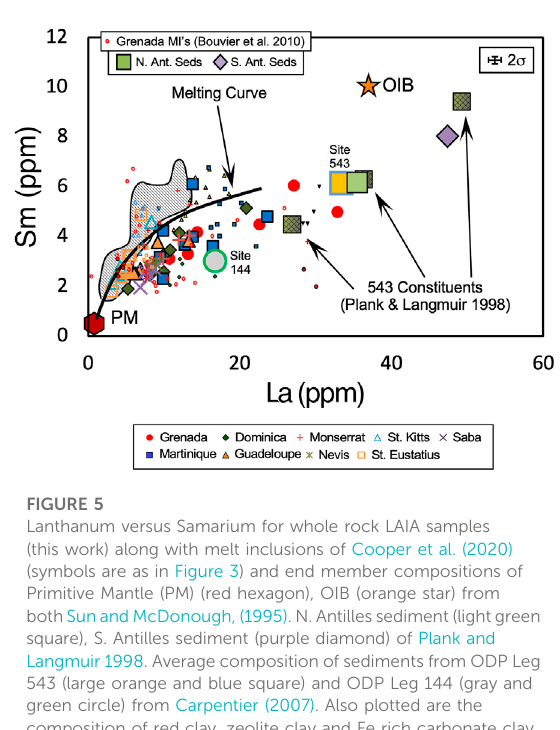
FIGURE 5 Lanthanum versus Samarium for whole rock LAIA samples (this work) along with melt inclusions of Cooper et al. (2020) (symbols are as in Figure 3) and end member compositions of Primitive Mantle (PM) (red hexagon), OIB (orange star) from bothSunandMcDonough,(1995).N.Antillessediment(lightgreen square), S. Antilles sediment (purple diamond) of Plank and Langmuir 1998. Average composition of sediments from ODP Leg 543 (large orange and blue square) and ODP Leg 144 (gray and green circle) from Carpentier (2007). Also plotted are